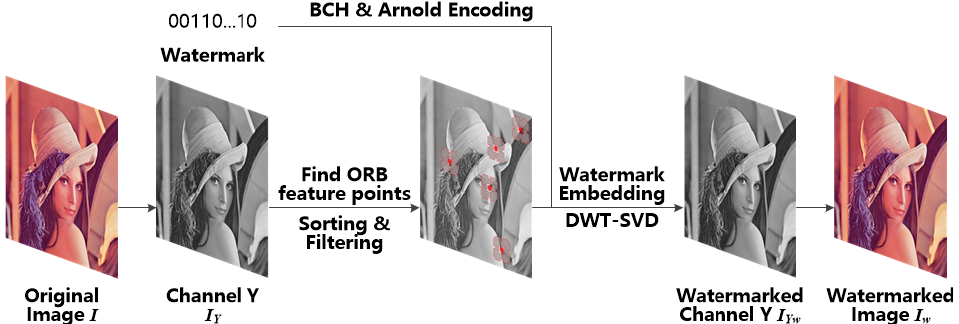
Figure 1. Watermark embedding